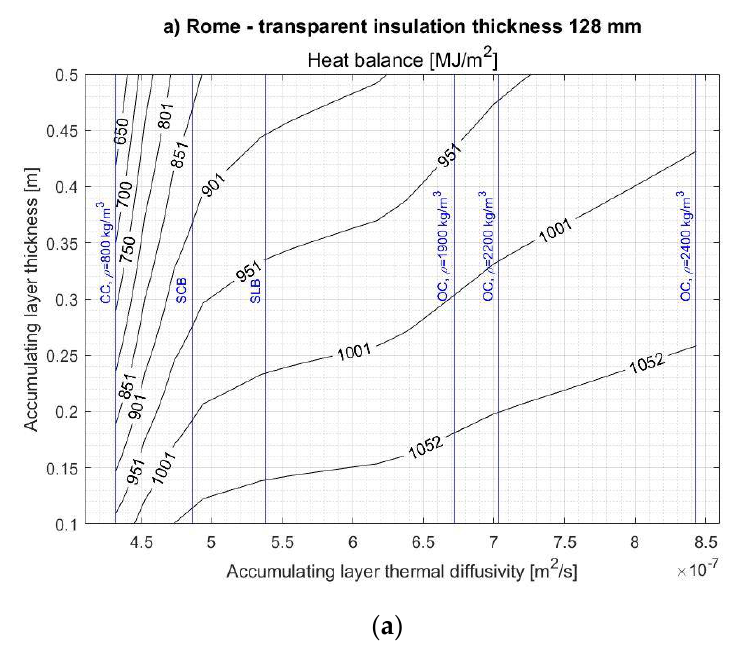
Figure A12. Cont